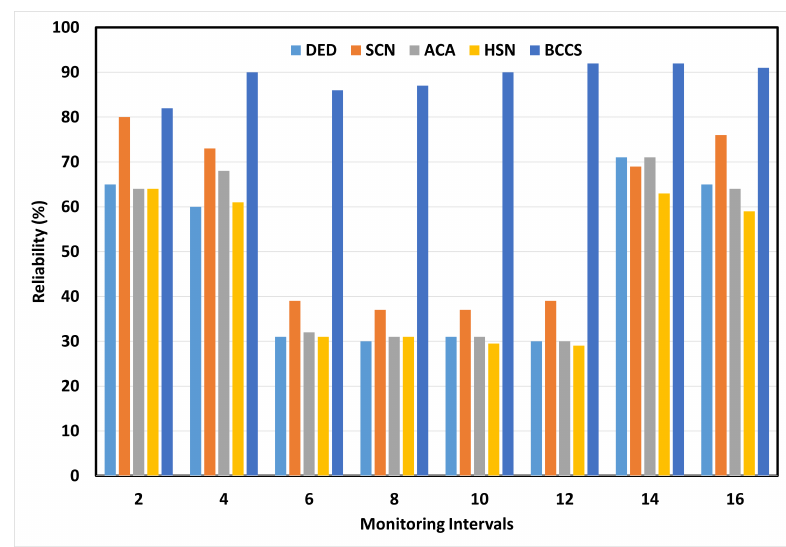
Figure 7. Reliability (monitoring intervals).